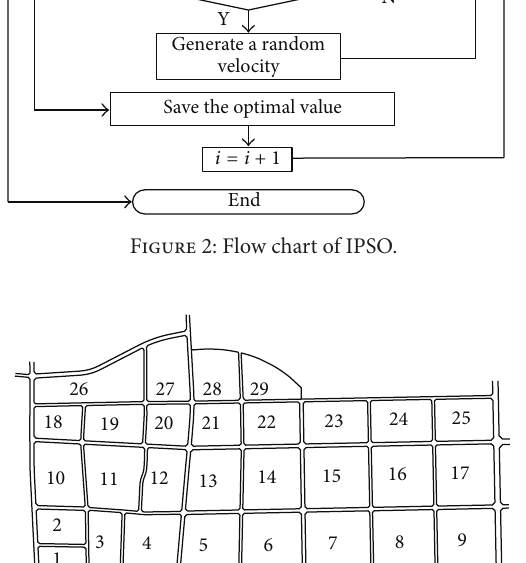
Figure 3: Site location plan of 29 heating